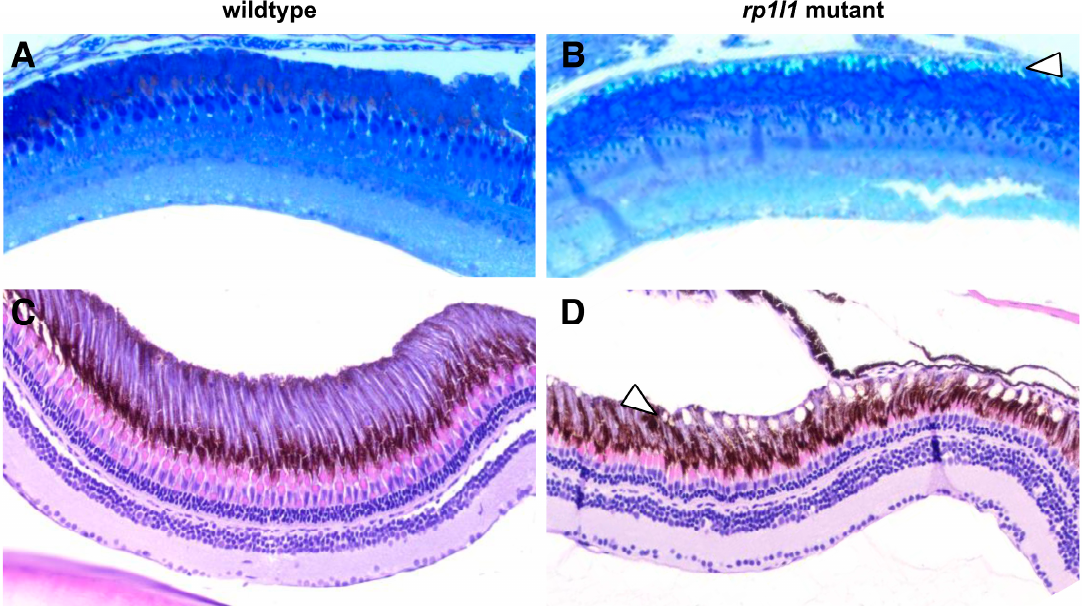
Figure 8. Mutant zebrafish retinas have subretinal deposits and short outer segments. Wild-type and mutant retina sections, stained with azure blue ( A , B ) or hematoxylin and eosin (H&E) ( C , D ). Deposits can be observed in the 11-month-old mutant azure blue-stained ( B ) sections between the photoreceptor outer segments and retinal pigment epithelium (arrowheads). H&E-stained sections of 12-month-old mutant retinas ( D ) show similar accumulations (arrowhead); however, the material that had filled the deposits was stripped from the tissue during processing. rp1l1 mutant retinas have shorter outer segments and thinner outer nuclear layers ( D ). No deposits were observed in the wild-type retinas ( A , C ).